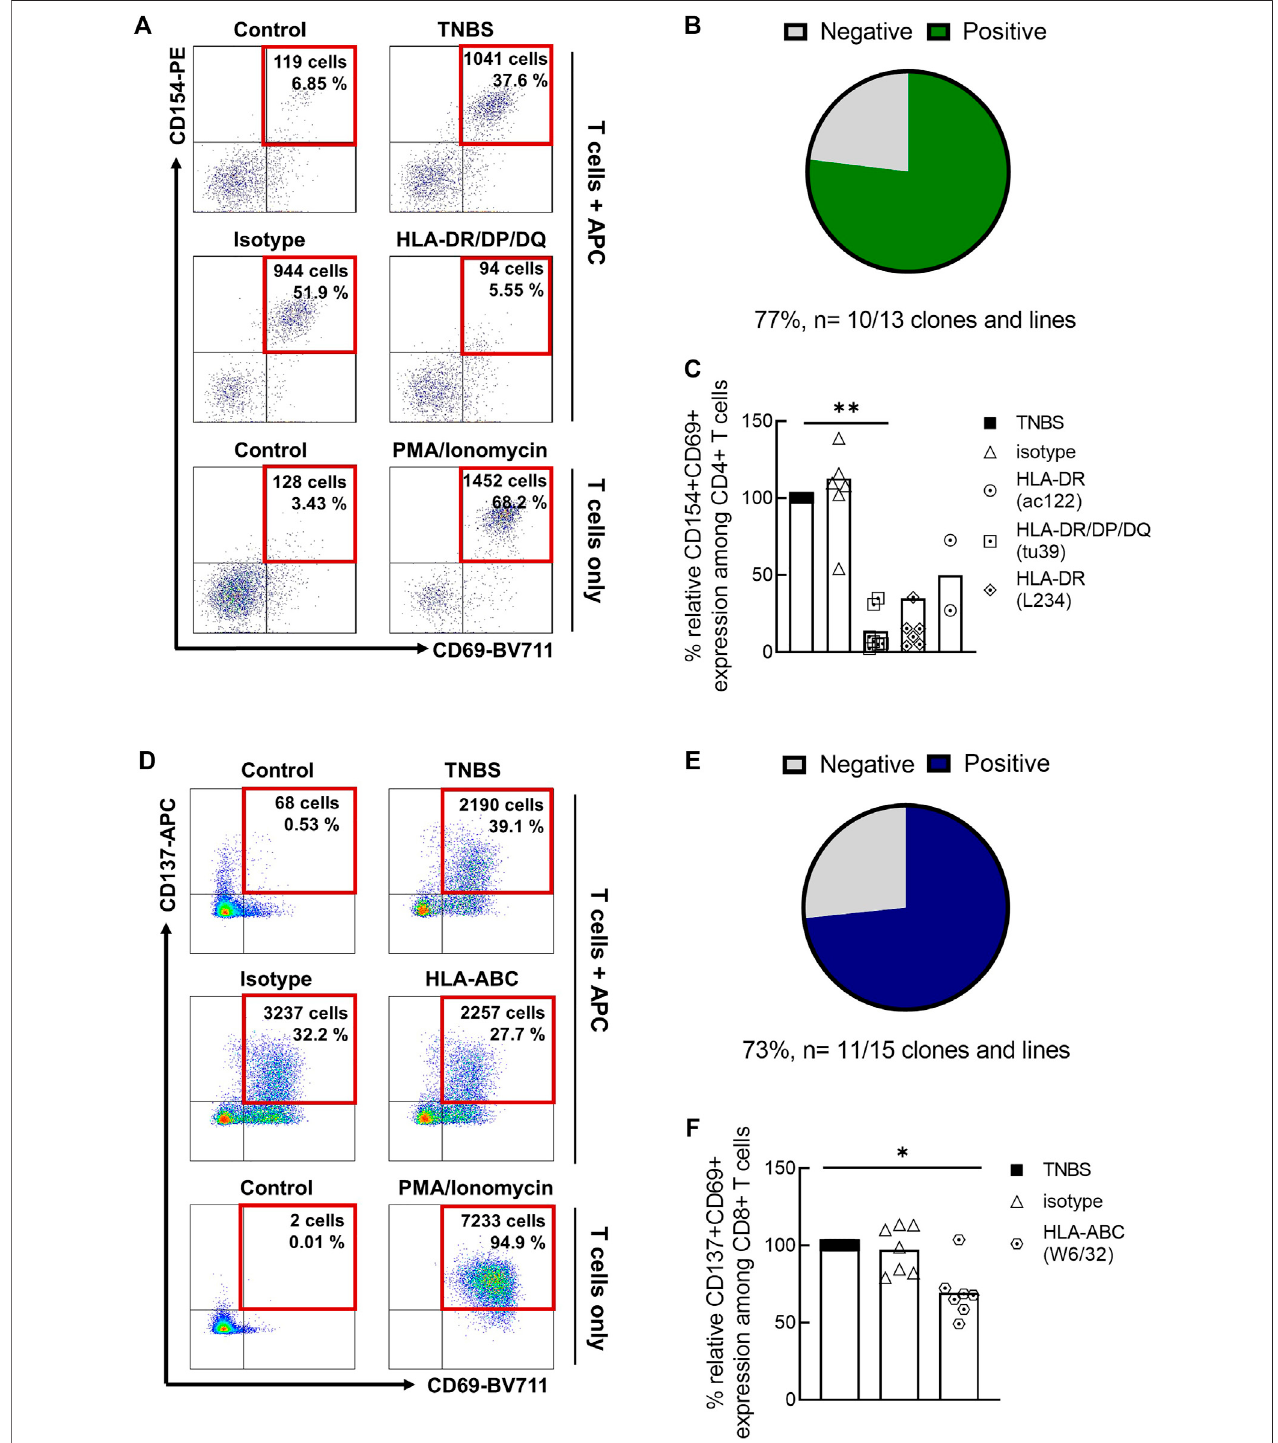
FIGURE 2 | Restimulation of TNBS-speci fi c T cells. TNBS-speci fi c CD154+CD4+ or CD137+CD8+ memory T cells were sorted from 5 to 16 h experiments, respectively. After in vitro expansion, cells were restimulated with TNBS-modi fi ed CD3-depleted autologous PBMC. (A,D) Representative dot plots for one CD4+ T cell clone[CACB3, (A) ] and one CD8+ T cell clone [MLB42a, (D) ]. Asa negative control, Tcells were incubated with PBS-modi fi ed APC (control). PMA/iono stimulation was used as a positive control for T cell reactivity. Gated on live, CD3+, single, CD4+ or CD8+ T cells. (B,E) Summary of restimulation experiments for TNBS-speci fi c CD4+ (B) andCD8+ (E) Tcellclonesandlines (listedin Supplementary TableS2 ). (C,F) MHCblockingexperiments.MHCIIorMHCIblockingantibodieswereadded to APC 30 min before incubation with T cells. Shown is the relative inhibition of induced CD154 and CD137 expression on TNBS-speci fi c CD4+ and CD8+ T cell clones and lines, respectively. Signals for stimulation with TNBS-modi fi ed APC without antibodies were set to 100%. White bars represent the mean values. Statistical signi fi cances were determined by one-way non-parametric ANOVA analysis (Kruskal-Wallis) with Dunn ’ s test as post-hoc test (* p < 0.05; ** p < 0.01 vs. TNBS).